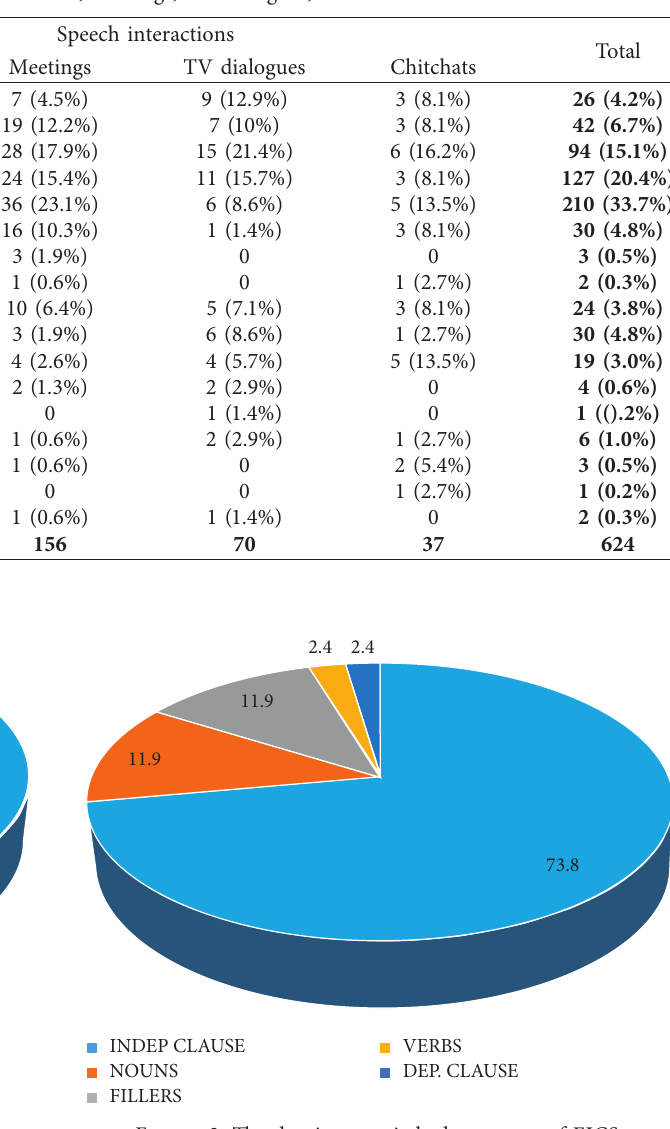
Table 1: The switched segments of seminars, meetings, TV dialogues, and chitchats.